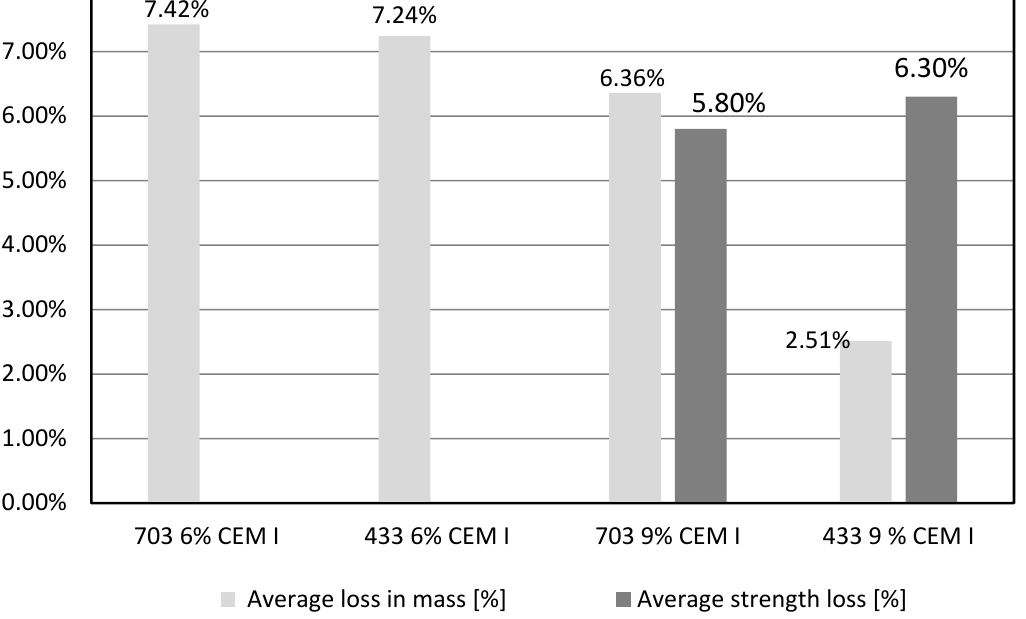
Figure 11. Average loss in mass and average strength loss after 25 cycles of freezing and defrosting for samples of rammed earth from different mixtures.